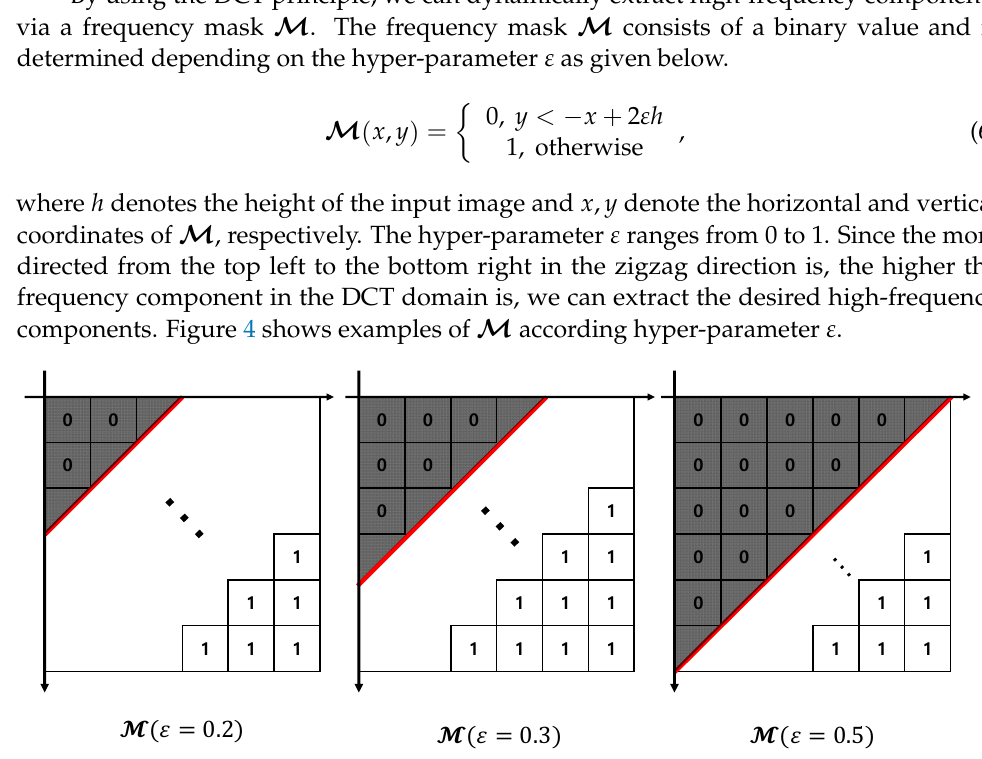
Figure 4. Examples of 𝓜 according to 𝜀 . Because of the larger hyper-parameter 𝜀 , more low-fre- quency components are masked. We empirically set 𝜀 to 0.2.